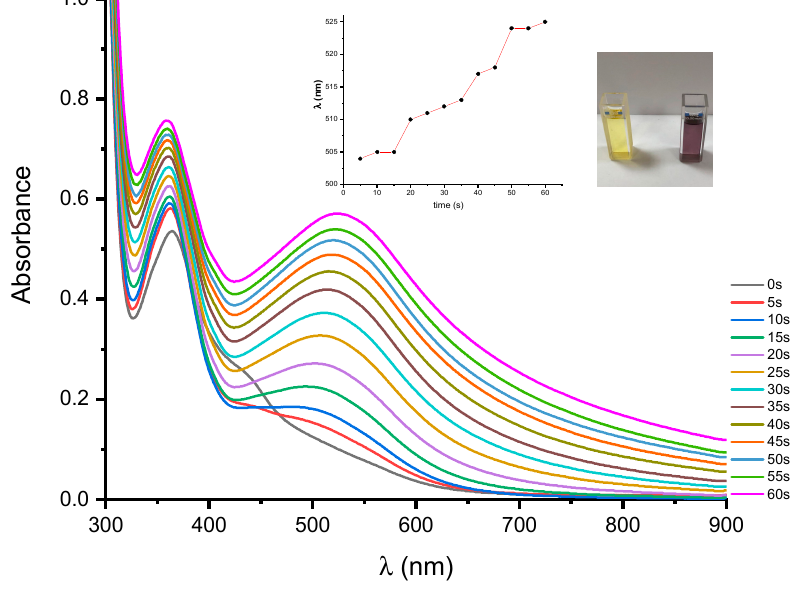
Figure 3. Evolution of the absorption spectra of the irradiated mixtures ( λ irr = 419 nm). Solution: HLCuCl 0.05 wt % gold chloride 4wt% and TEA 1 wt% dissolved in 25 mL of DMF.